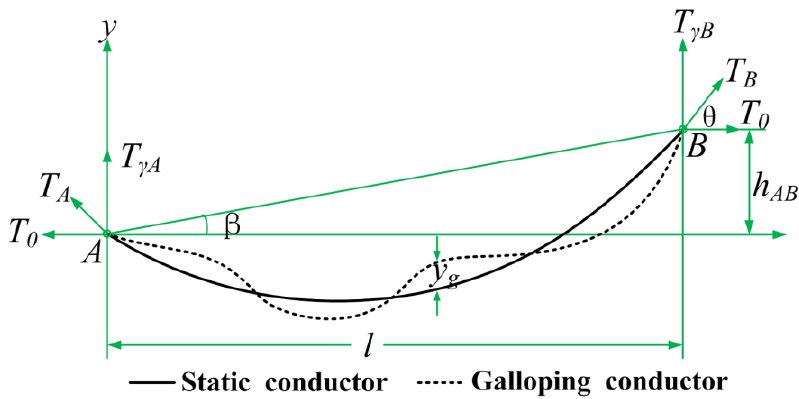
Figure 3 . The model of conductor galloping with different height suspension points. Figure 3. The model of conductor galloping with different height suspension